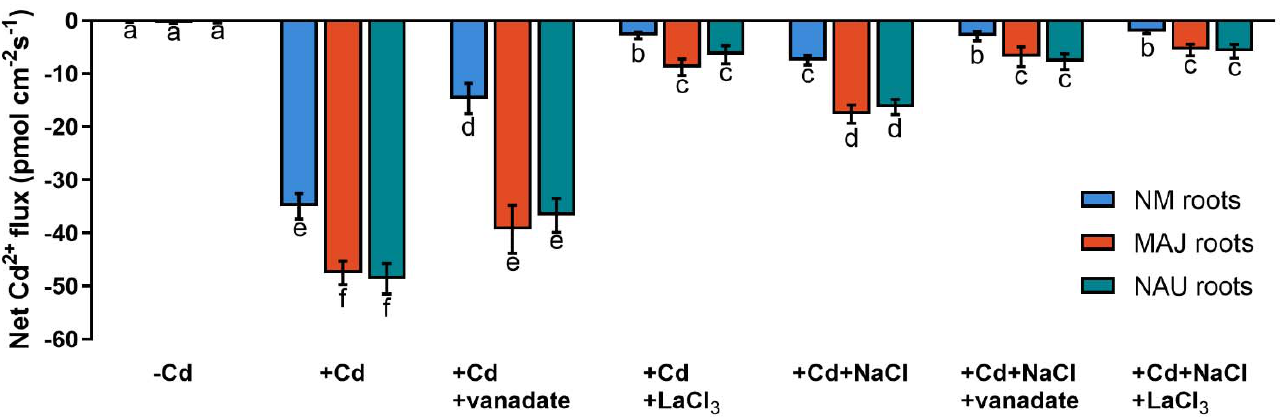
Figure 5. Net Cd 2+ fluxes in non-mycorrhizal (NM) Populus × canescens and ectomycorrhizal (EM) roots under cadmium, salt, and inhibitor treatments. Poplar plantlets inoculated with or without Paxillus involutus isolates (MAJ or NAU, 30 d), were hydroponically acclimated and subjected to 24 h of CdCl 2 (0 or 50 µ M) in combination with NaCl (0 or 100 mM). Root tips were excised from EM- and NM-poplars and subjected to an inhibitor of plasmalemma H + -ATPase (sodium orthovanadate, 0 or 500 µ M) or an inhibitor of Ca 2+ -permeable channels (LaCl 3 , 0 or 5 mM) for 30 min. Following 30 min equilibration in measuring solutions, net fluxes of Cd along root axis (100 to 2300 µ m) were monitored at an interval of 200–300 µ m (Figures S2 and S3). Mean values of Cd 2+ fluxes in control ( − Cd), CdCl 2 stress (+Cd), and combined stress of CdCl 2 and NaCl (+Cd + NaCl) in the presence and absence of inhibitors are shown. Cd 2+ flux was not detectable in salt controls that were treated without CdCl 2 . Each column is mean ± SD obtained from 5 individual plants. Statistically significant differences ( p < 0.05) among treatments are indicated with different letters (a–f).